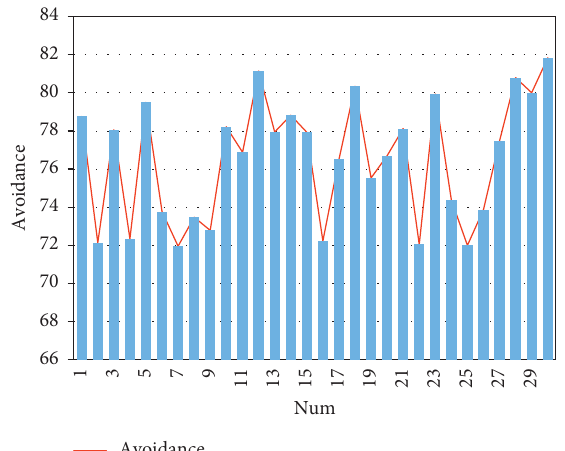
Figure 10: Statistical diagram of the obstacle avoidance efect of the robot based on deep